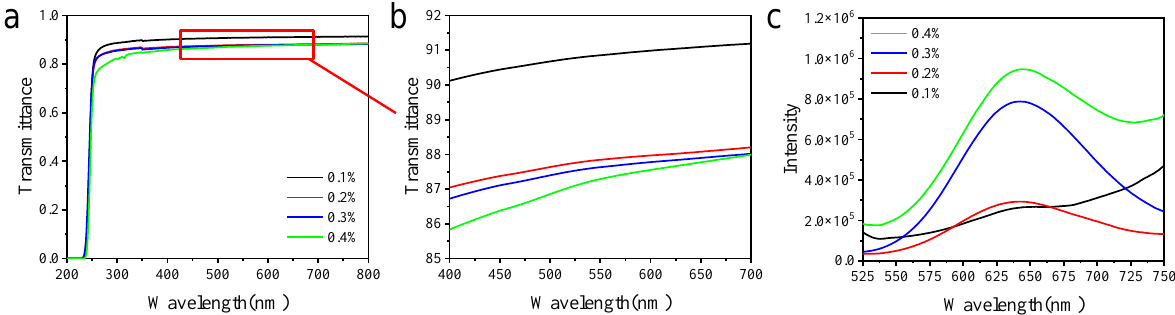
Figure 4. ( a ) transmittance of films with different doping concentrations. ( b ) transmittance of films with different doping concentrations (400–700 nm). ( c ) FL of films with different doping concentrations (from 0.1% to 0.4%).